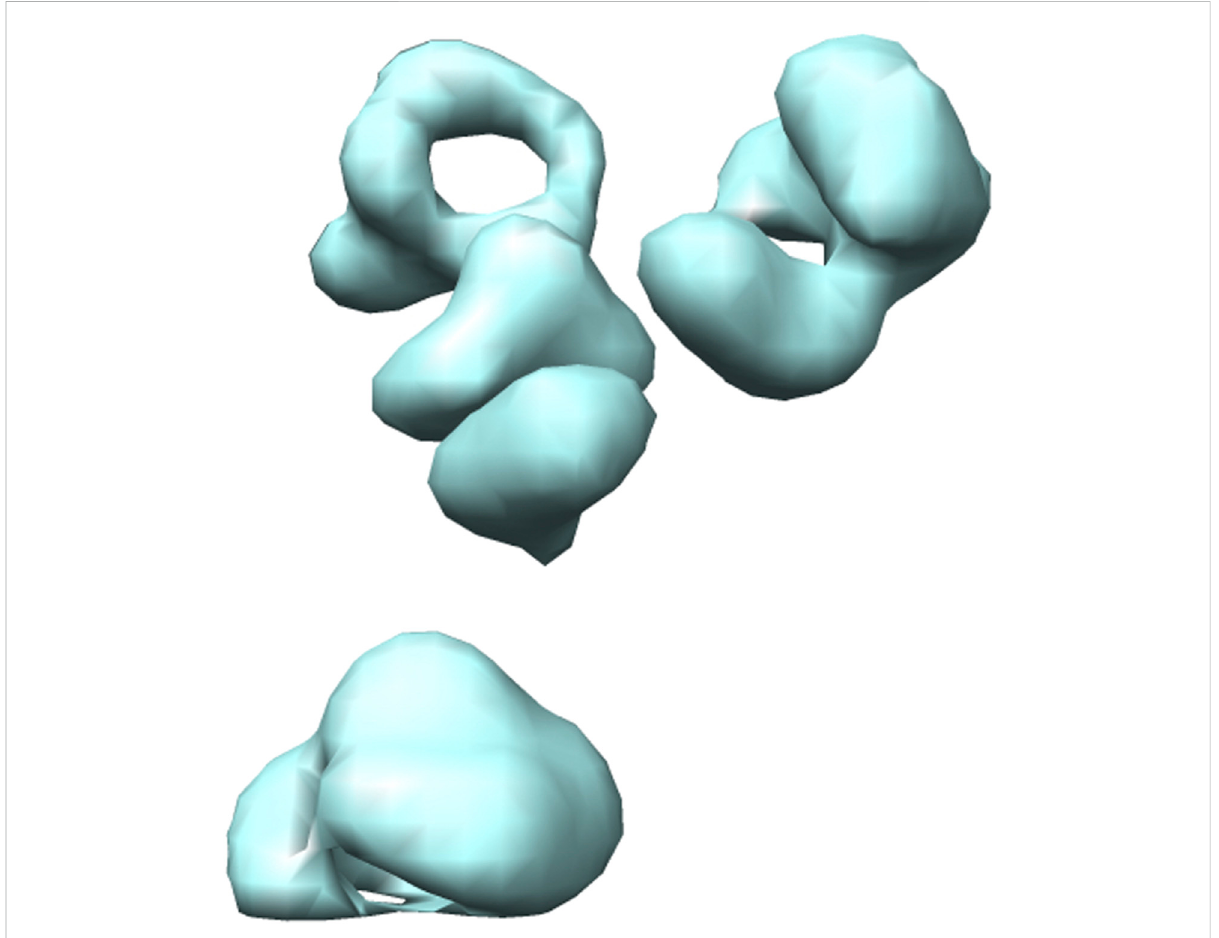
FIGURE 4 3Disosurfacevisualizationofsimulated2h12macromolecule,alongwithrandomlysimulatedmacromoleculesdepictingacrowdedsubcellular